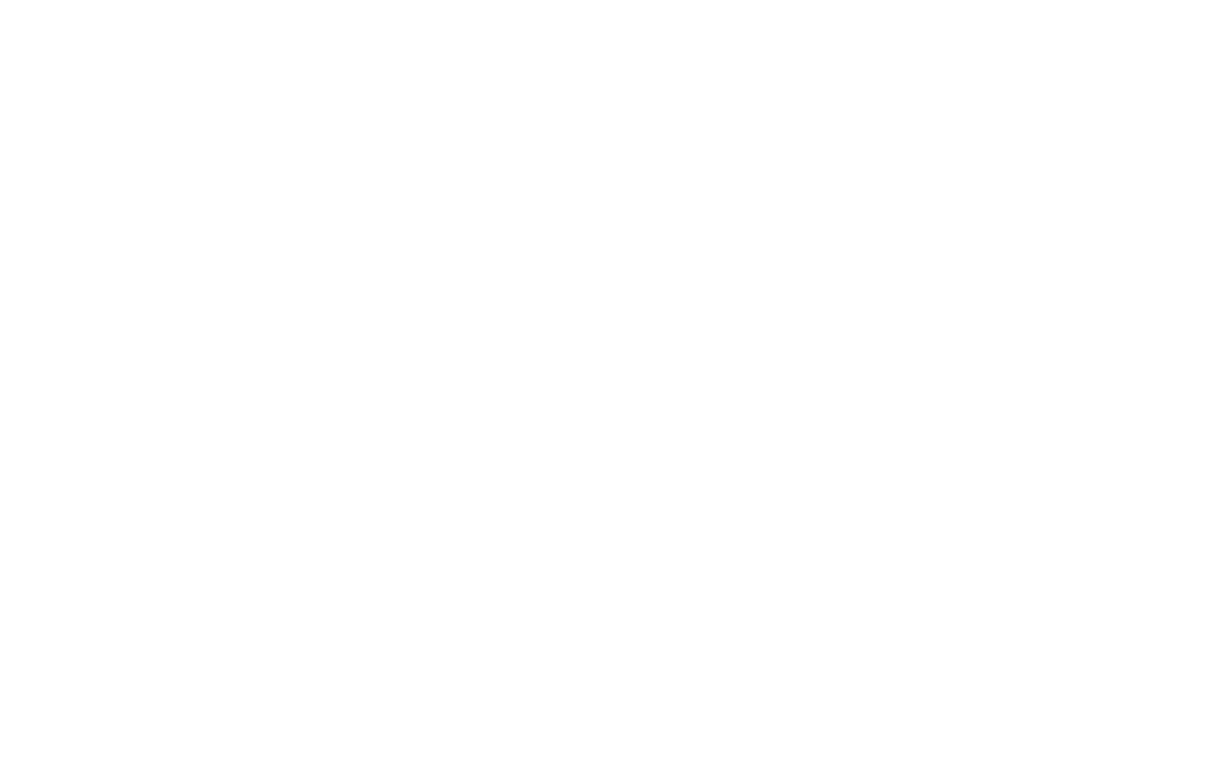
FIGURE 10 | (A) Representation of the frame-averaged motion-compensated data, frame-averaged data reconstructed after the IDLE, EMSC and OTFP analysis and reconstruction residuals. (B) Two-dimensional scores plot resulting from a PCA decomposition of the (pathlength-corrected) frame-averaged reconstructed data. Archetypal frames are highlighted in light grey and connected by a dashed-dotted grey line. The evolution of the scores from right to left follows the hyperspectral video progression from its beginning to its end. (C) First and (D) second component loadings yielded by the aforementioned PCA decomposition. PC and EV stand for Principal Component and Explained Variance ,